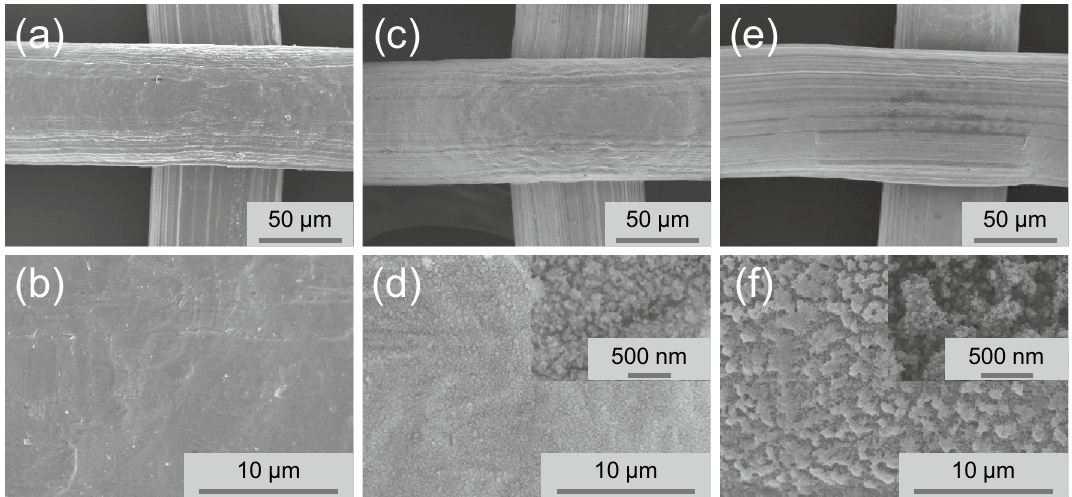
Figure 2. SEM images of an untreated stainless steel mesh ( a , b ), plasma treated mesh with case 1 ( c , d ) and case 2 ( e , f ).